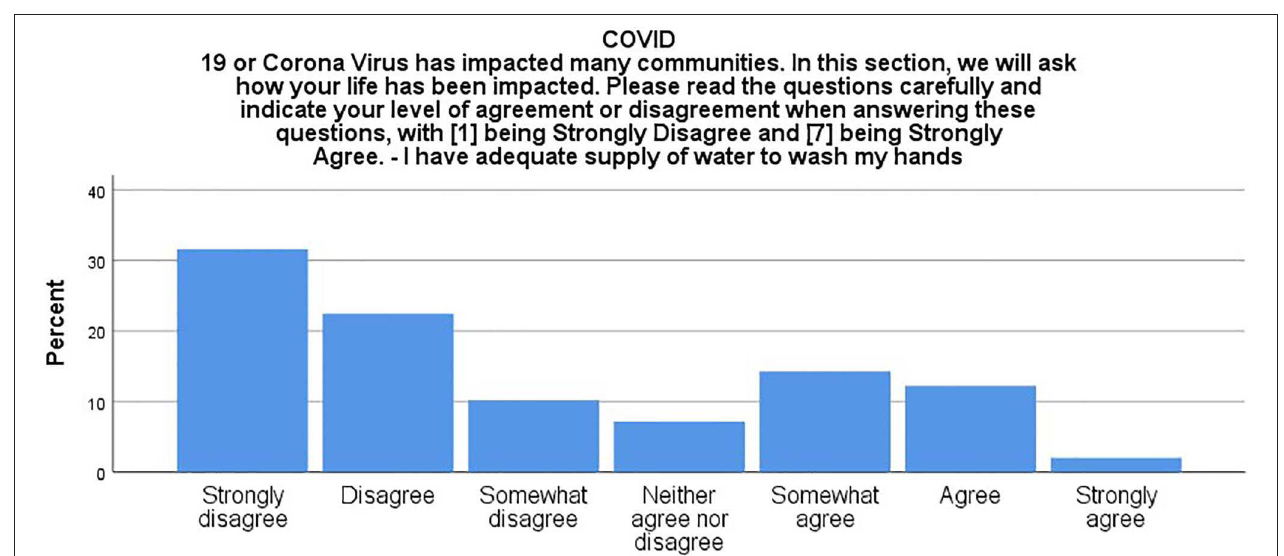
FIGURE 6 | Distribution of participants reporting adequate supply of water to wash